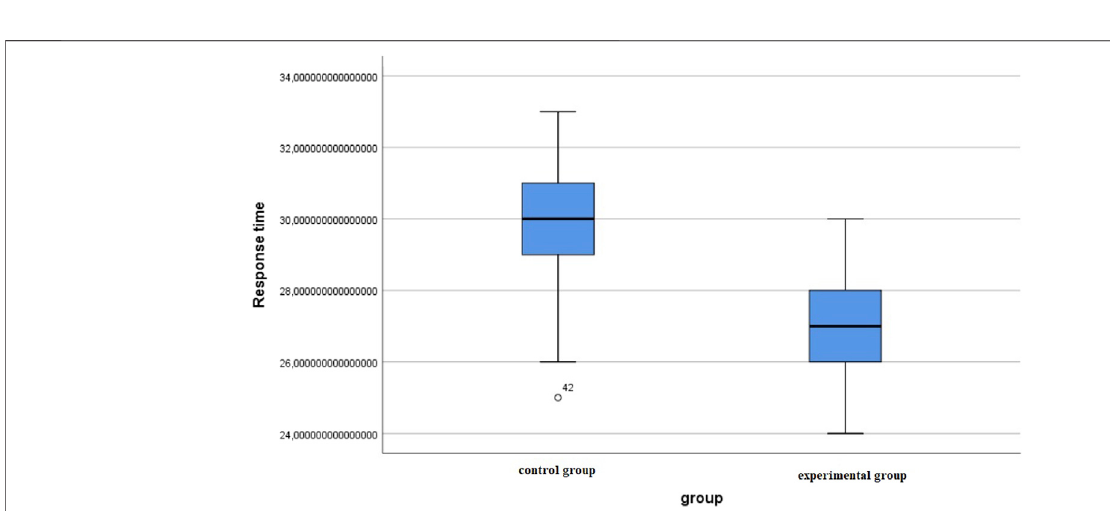
FIGURE 6 | Distribution of learning style based on Kolb ’ s test.